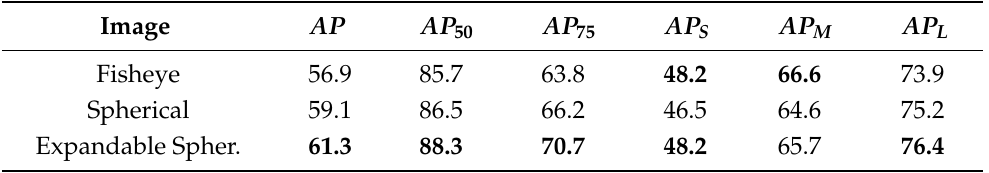
Table 1. Accuracy of different projections of YOLOv3-SPP model on Fisheye-KITTI. (In the all accuracy analysis tables, the bold-typed number is the best performance in each